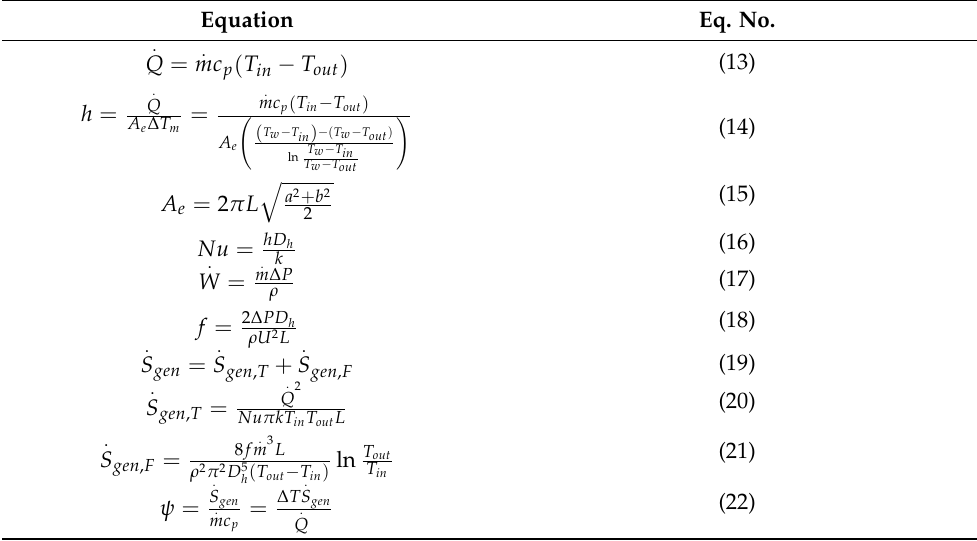
Table 6. Implemented thermal hydrodynamic equations in the model